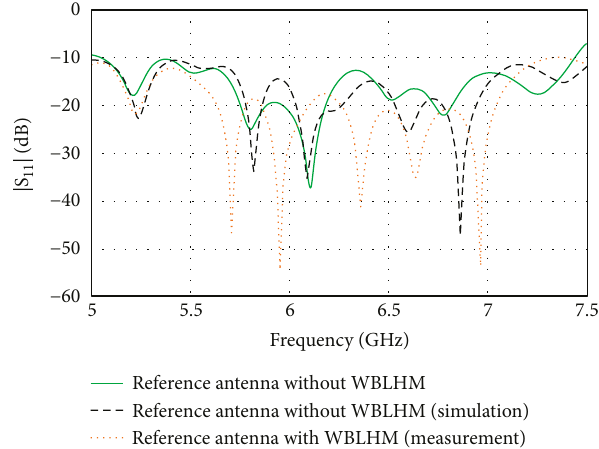
Figure 6: Simulated and measured S and without WBLHM